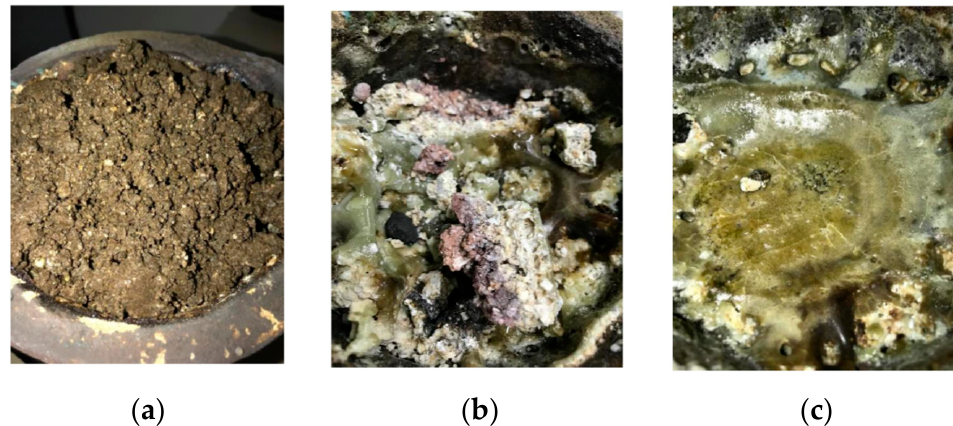
Figure 5. Photo of phosphate waste: ( a ) before treatment, ( b ) after 30 min of treatment, and ( c ) after 40 min of treatment.